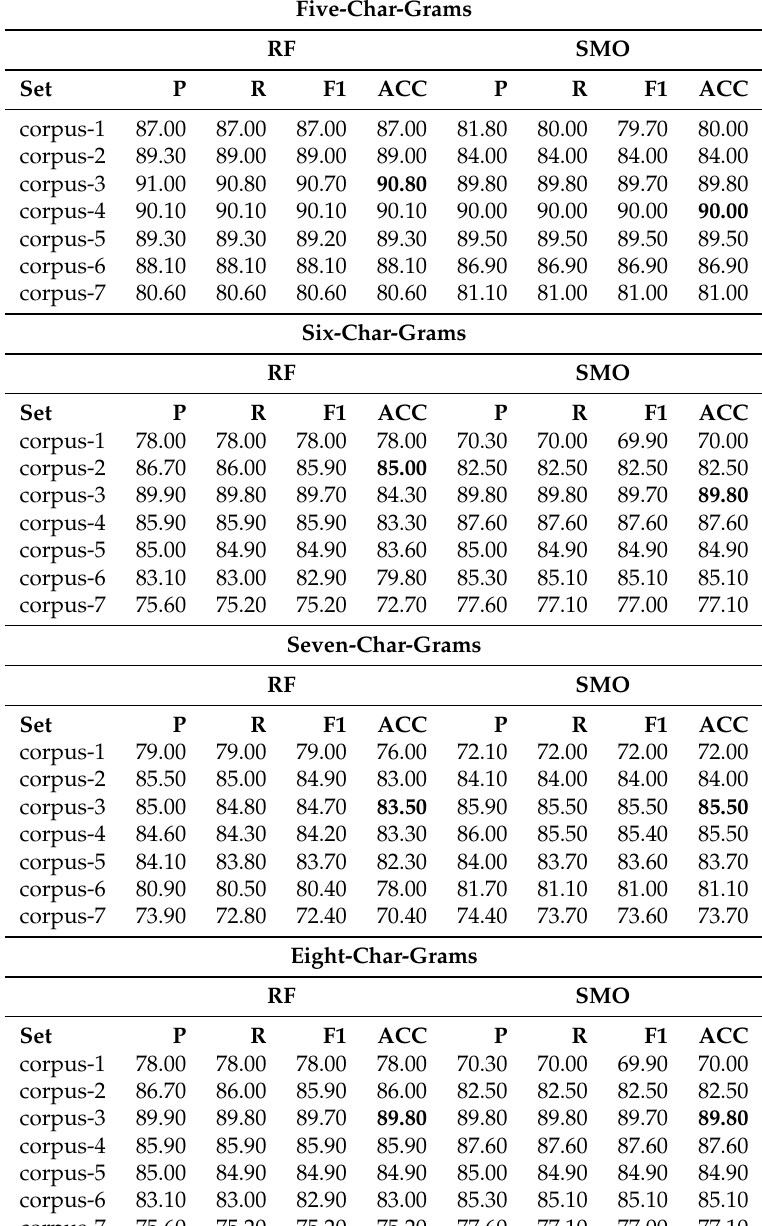
Table 5. Results with five-, six-, seven- and eight-length